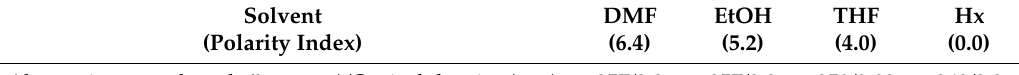
Table 1. Photophysical characteristics of salicylaldazine (SAA) (10 − 4 M) in di ff erent solvents. Solvent (Polarity